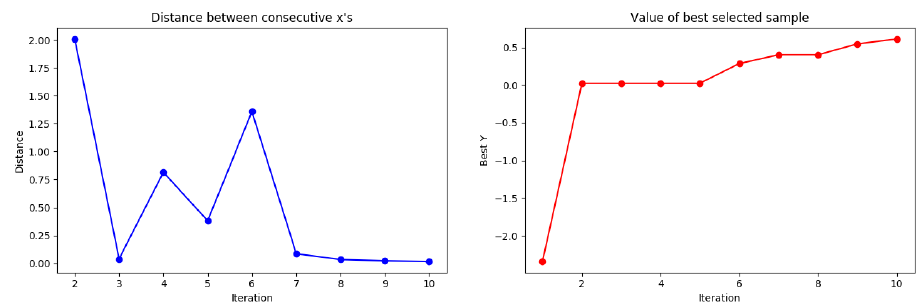
Figure 5. Tested results of distances and the best selected samples to Gaussian distribution.